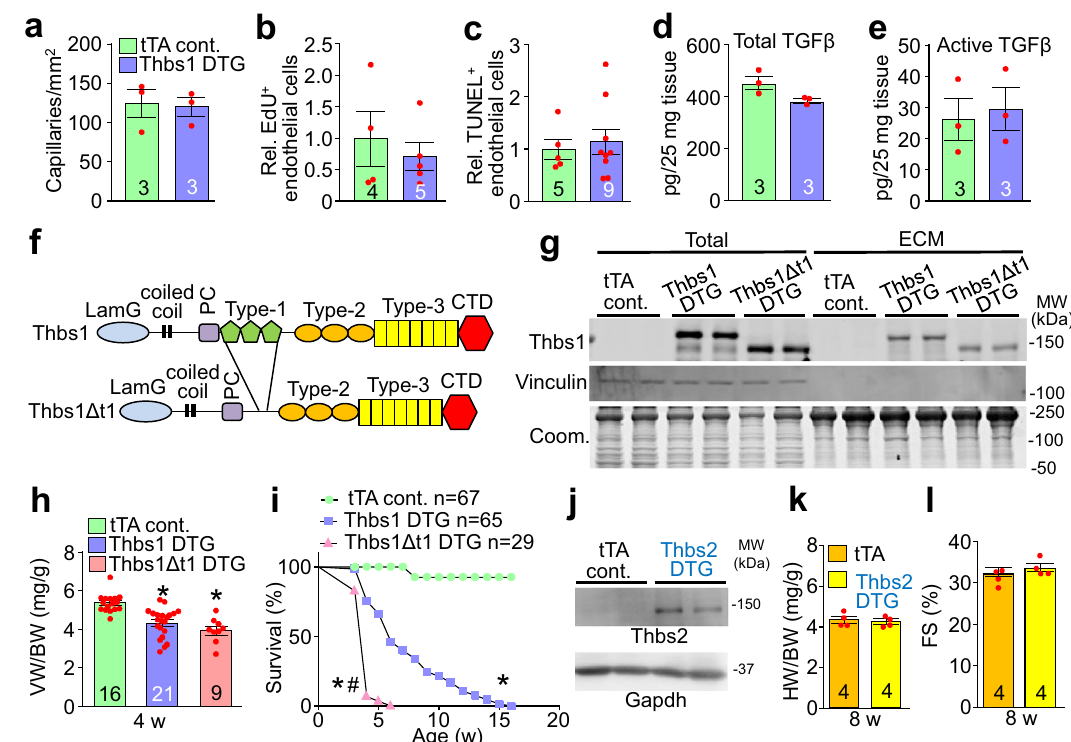
Fig. 3 Endothelial cells and TGF β are not affected by cardiac Thbs1 overexpression. a Quanti fi cation of capillary number per mm 2 of tissue from histological sections of tTA cont. and Thbs1 DTG hearts stained with isolectin B4 at 6 weeks of age. b Quanti fi cation of endothelial cell proliferation as measured by EdU incorporation co-labeled with CD31 in tTA cont. and Thbs1 DTG hearts at 6 weeks of age. c Quanti fi cation of endothelial cell apoptosis detected by TUNEL staining co-labeled with isolectin B4 in tTA cont. and Thbs1 DTG hearts at 6 weeks of age. d ELISA-based quanti fi cation of total TGF β and e active TGF β in protein extracts from tTA cont. or Thbs1 DTG hearts at 6 weeks of age. f Schematic diagram of WT Thbs1 domain structure and the Thbs1 Δ t1 mutant lacking the Thbs1 type-1 repeat domain region. g Representative western blot analysis for Thbs1 from total protein extracts (Total) and extracellular matrix (ECM) extracts from hearts of tTA cont., Thbs1 DTG, and Thbs1 DTG Δ t1 mice at 4 weeks of age. Vinculin is presented as cytosolic control. Coomassie stained (Coom.) gel is shown as loading control. h VW/BW ratio at 4 weeks of age in the indicated groups of mice. * P < 0.0001 versus tTA cont.; statistical analysis was performed using one-way ANOVA and Tukey multiple comparisons test. i Kaplan – Meier survival plot of tTA cont., Thbs1 Fig. 2e are shown again here for tTA cont. and Thbs1 DTG mice (same strain and ages and sex ratio mix). j Representative western blots for Thbs2 and Gapdh as loading control, from heart protein extracts from tTA cont. and Thbs2 DTG mice at 8 weeks of age. k Heart weight (HW)/BW ratio, and l FS percentage at 8 weeks of age from tTA cont. and Thbs2 DTG mice. The number of biologically independent animals analyzed is indicated on each graph. Error bars are ±standard error of the mean. Source data are provided as a Source Data